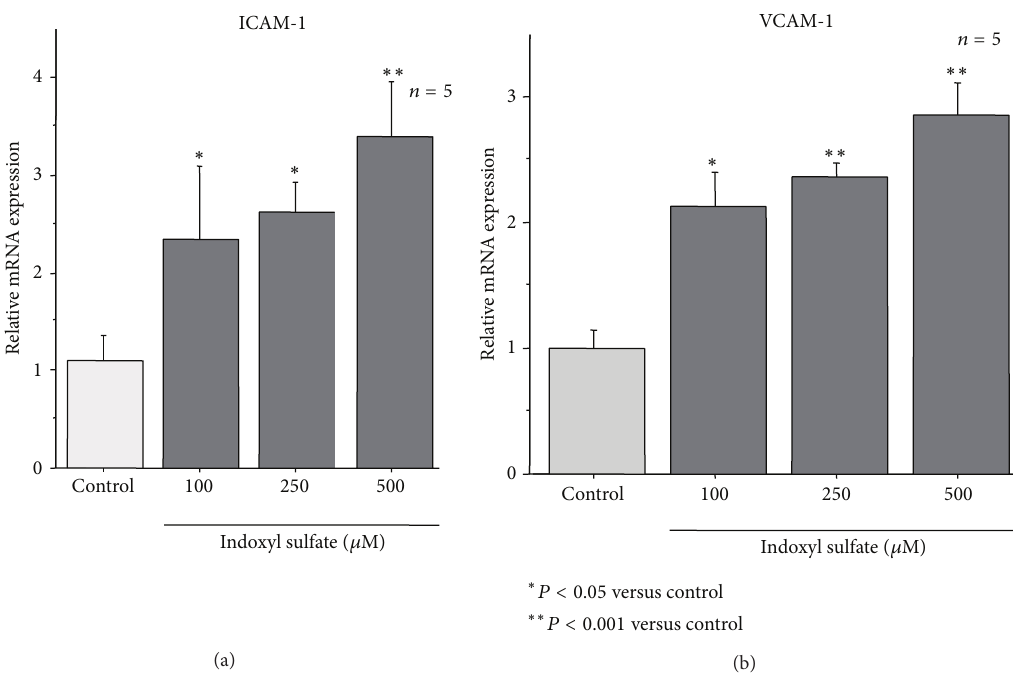
Figure 5: Expression of ICAM-1 and VCAM-1 mRNA in HUVECs. Expressions of adherence factors; ICAM-1 and VCAM-1 mRNA were examined to clarify the effect of IS on synthesis of HUVECs in vitro ( 𝑛 = 5 ). Both syntheses of ICAM-1 and VCAM-1 mRNA were accelerated by IS in dose-dependent manner. ∗ 𝑃 < 0.05 compared to the control group. ∗∗ 𝑃 < 0.001 compared to the control